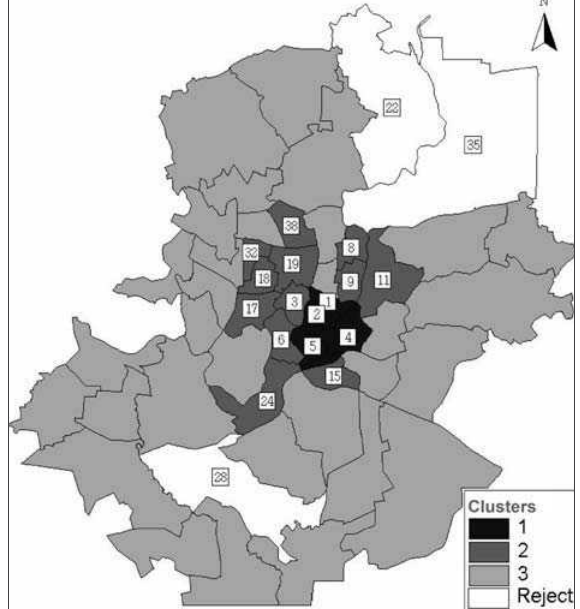
Fig 6. Vilnius districts are distributed into three